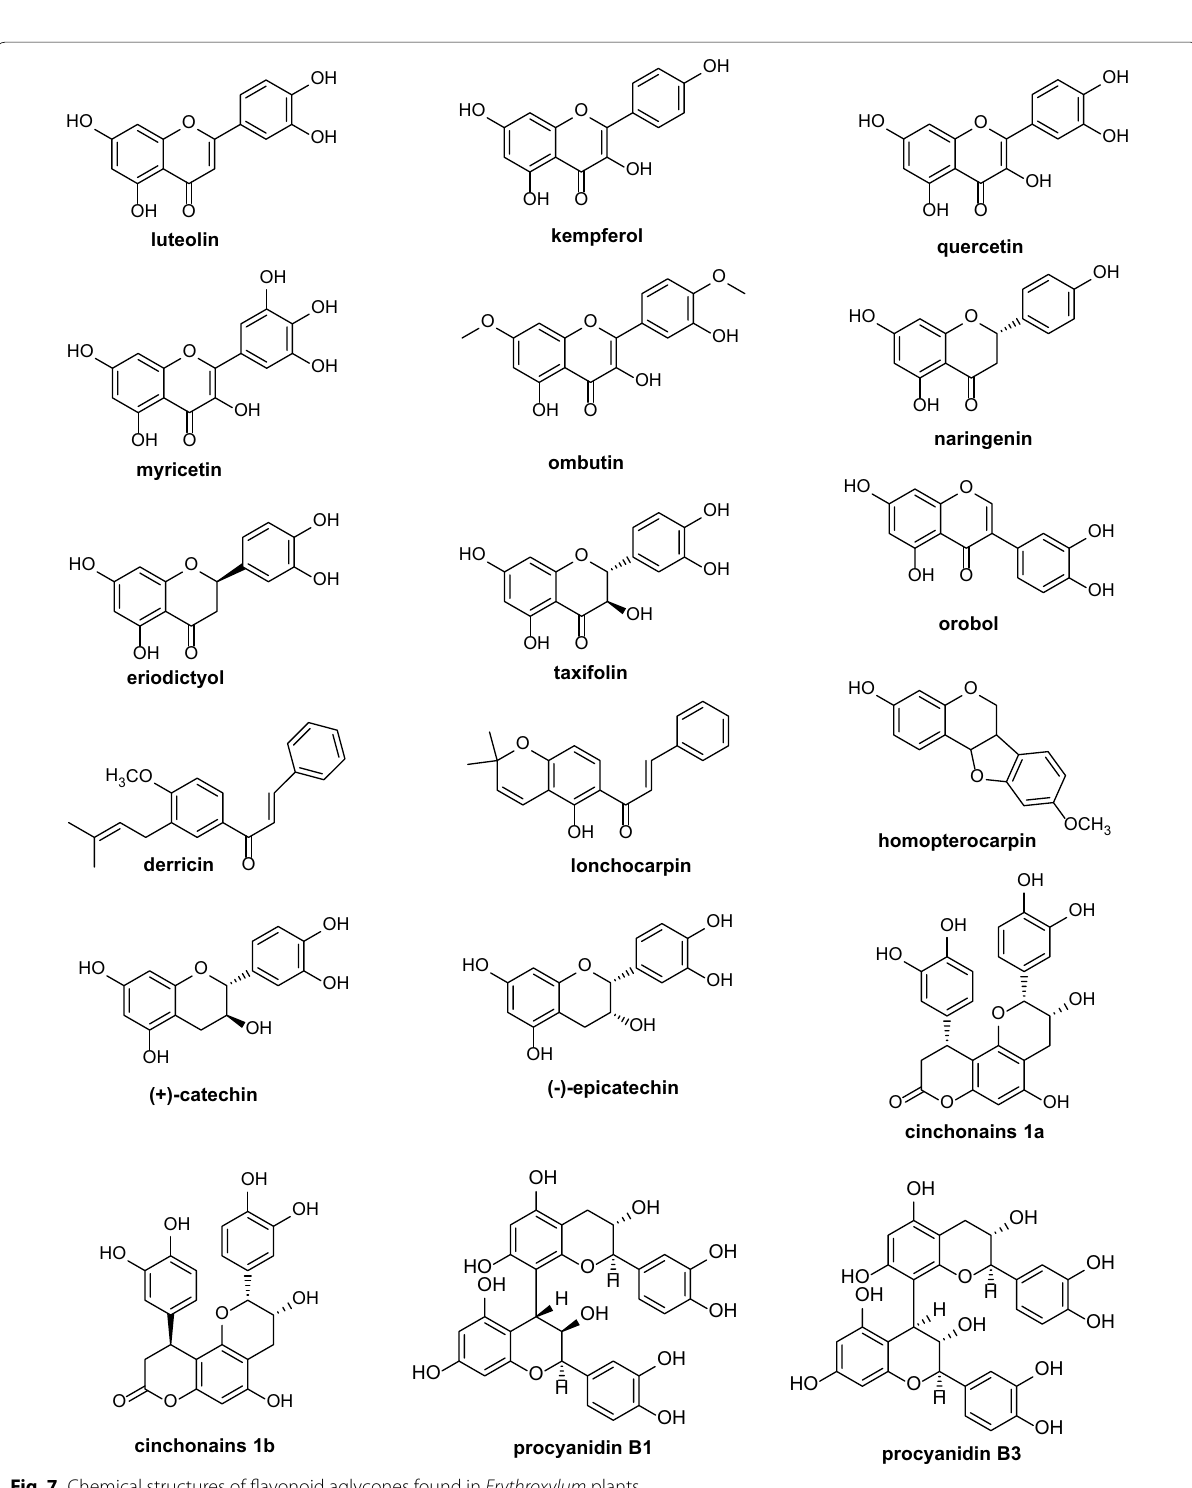
Fig. 7 Chemical structures of flavonoid aglycones found in Erythroxylum